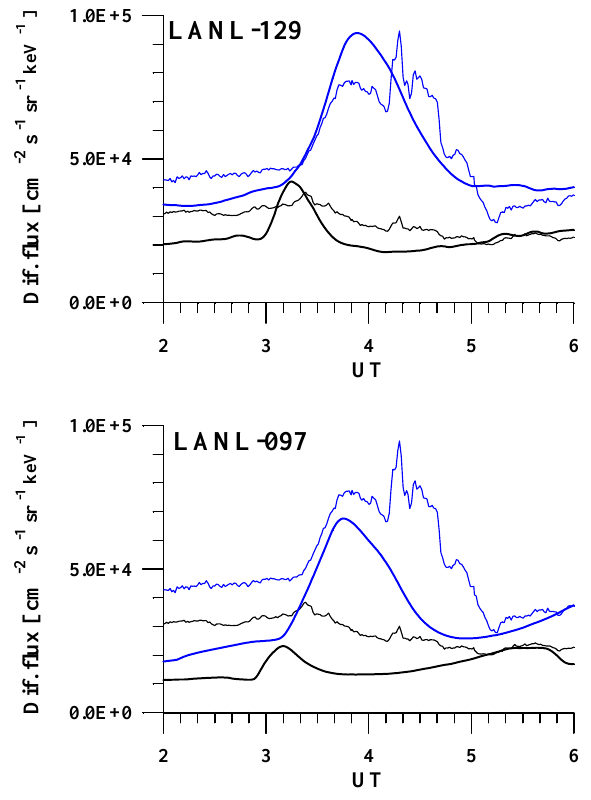
Fig. 8. Omnidirectional differential fluxes at 50–75 and 75–105keV (the blue and black line, respectively). The fluxes obtained onboard the LANL-046 satellite are shown by the thin line. Results of trac- ing of the fluxes detected by the LANL-129 (top) and LANL-097 (bottom) satellites to the longitude of the LANL-046 satellite are shown by the bold